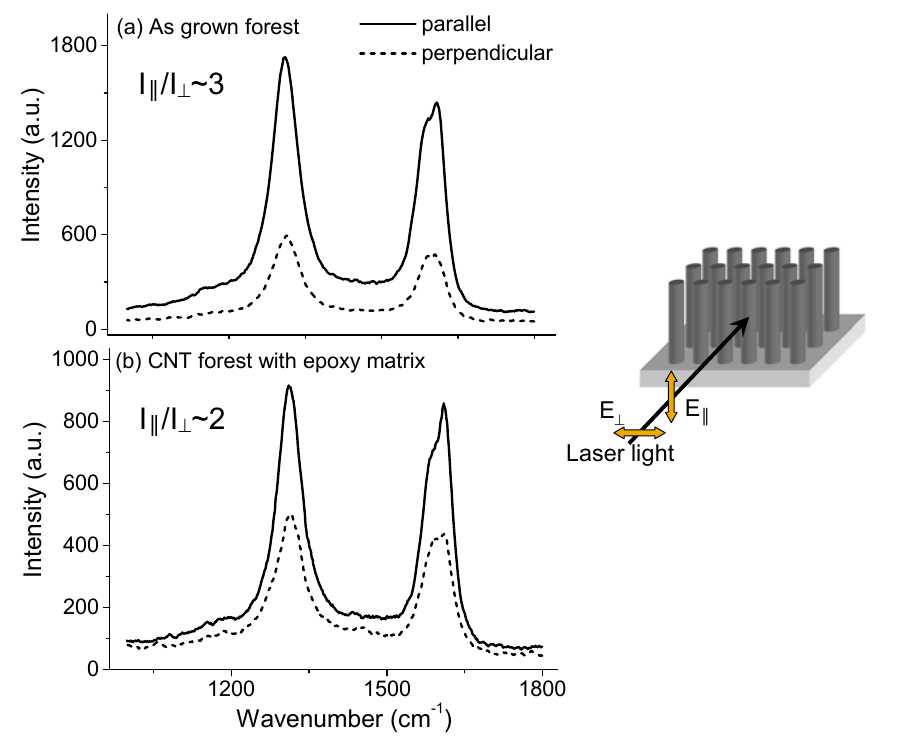
Figure 14. Raman spectra taken from (a) an as grown CNT forest and (b) a forest after infiltrating with epoxy. Both the D (1,310 cm -1 ) and G (1,590 cm -1 ) bands are present. The Raman signal intensity is sensitive to the CNT alignment and is strongest when the incident polarization is parallel to the CNT axis. It can therefore give an indication of the CNT alignment. A 783 nm laser with incident power of 2 × 10 4 W/cm 2 was used to avoid luminescence from the epoxy resin (see supplementary material).